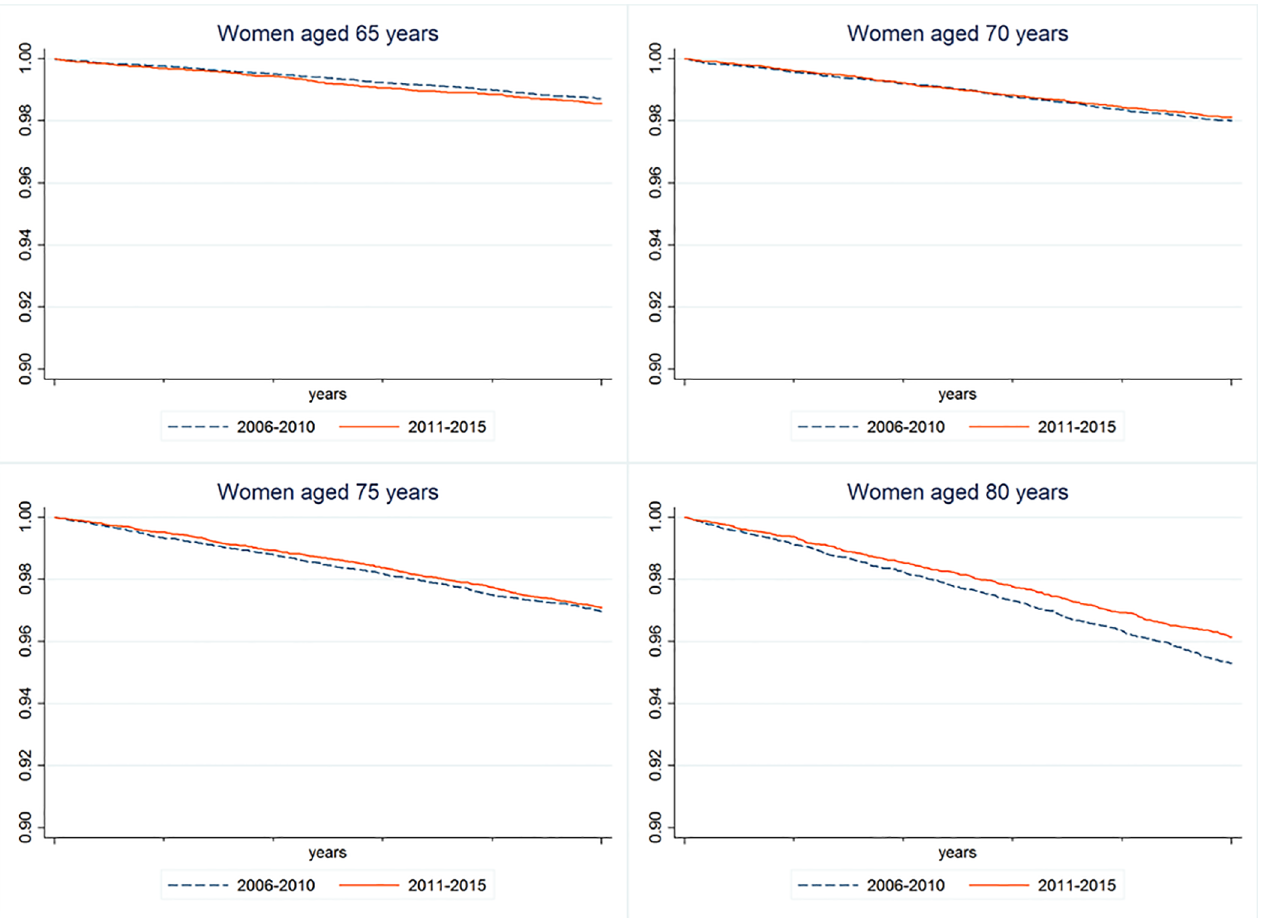
Fig 2. Survival curves of MI-onsets in women of different age groups (65–69 yrs., 70–74 yrs., 75–79 and 80–84 yrs.) for two periods (2006–2010 and 2011–2015).